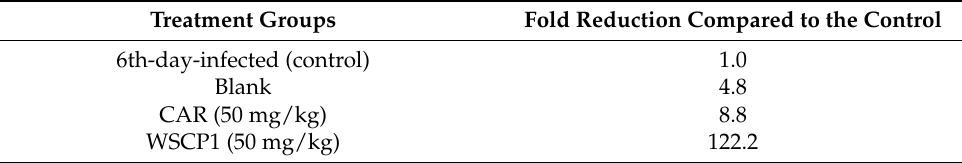
Table 4. Treatment groups with fold reduction compared to the control group.